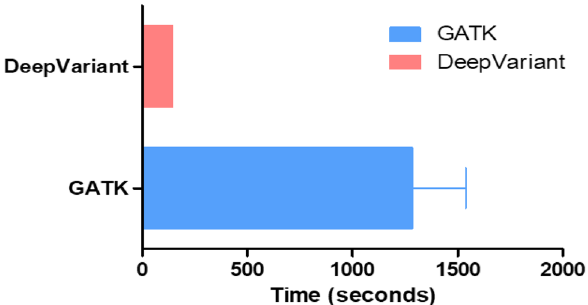
Figure 1. Variant calling execution time of GATK and DeepVariant for one typical trio exome analysis.